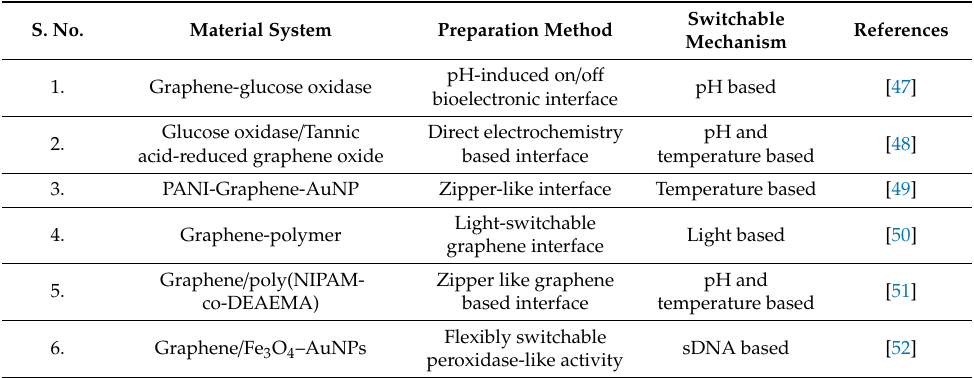
Table 1. Graphene-based switchable